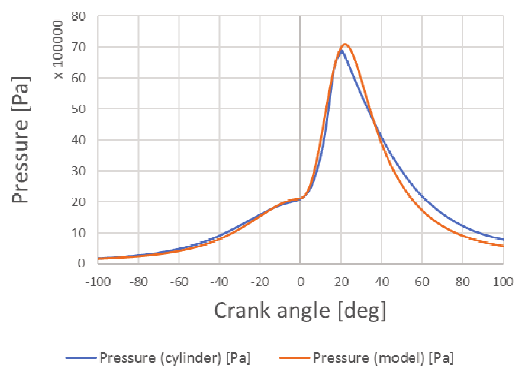
Fig. 13 Preliminary results from PAMAR-4 engine vs 0D